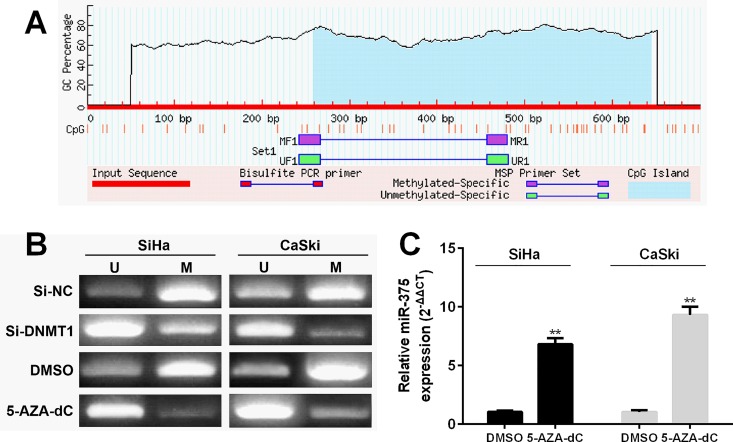
MiR-375 is downregulated due to promoter hypermethylation mediated by DNMT1.A. Bioinformatics analysis of CpG island in promoter regions of miR-375 and the location of methylated and unmethylated primers used for MSP analysis. B. SiHa and CaSki cells transfected with DNMT1 siRNA or treated with 5-AZA-dC were used for MSP assay and the products were separated electrophoretically on 2% agarose gels. M, amplification with methylated primers; U, amplification with unmethylated primers. C. QRT-PCR analysis of miR-375 expression in SiHa and CaSki cells with or without the treatment of 5-AZA-dC. ** p<0.01.